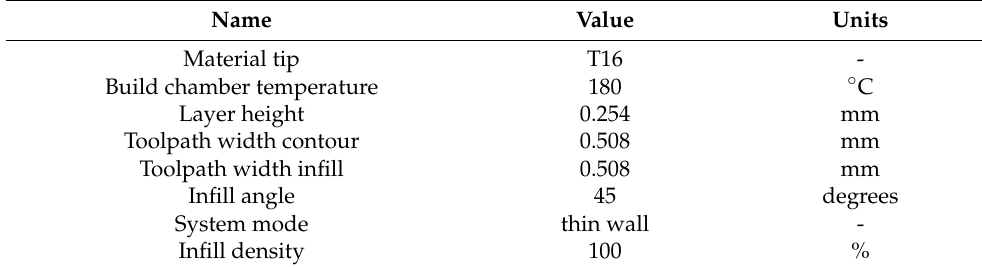
Table 3. Manufacturing parameters for the spare